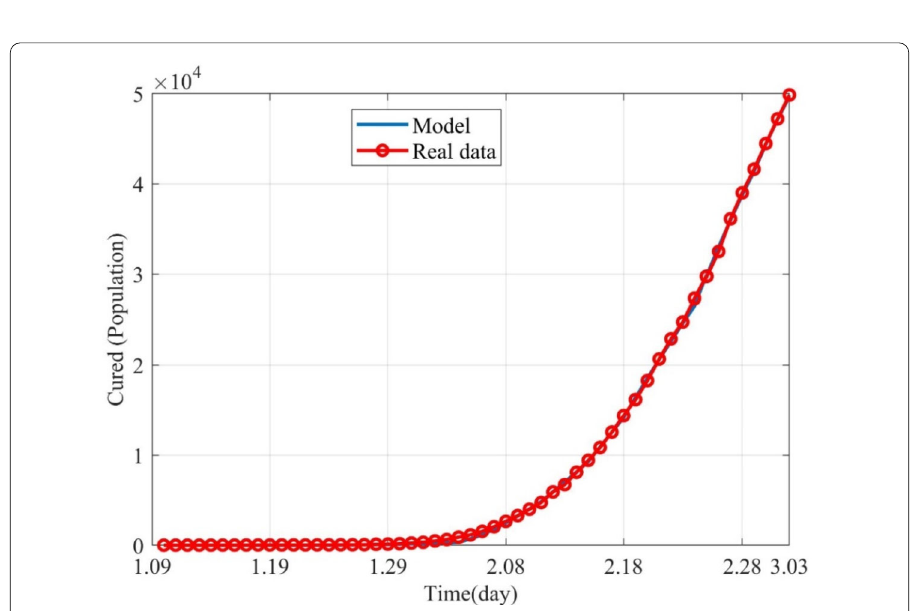
Figure 7 Dynamic trends of the cured. The blue line represents the simulation of SEIR model, and the red line represents the data issued by NHCC